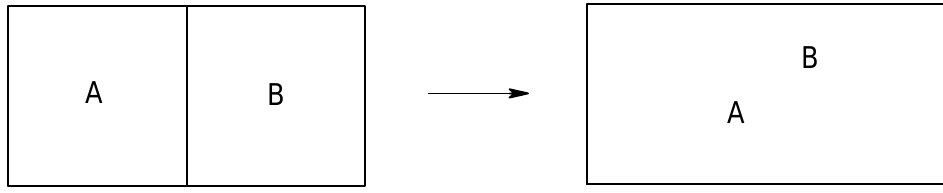
Figure 8. Ideal gas mixing in a rigid